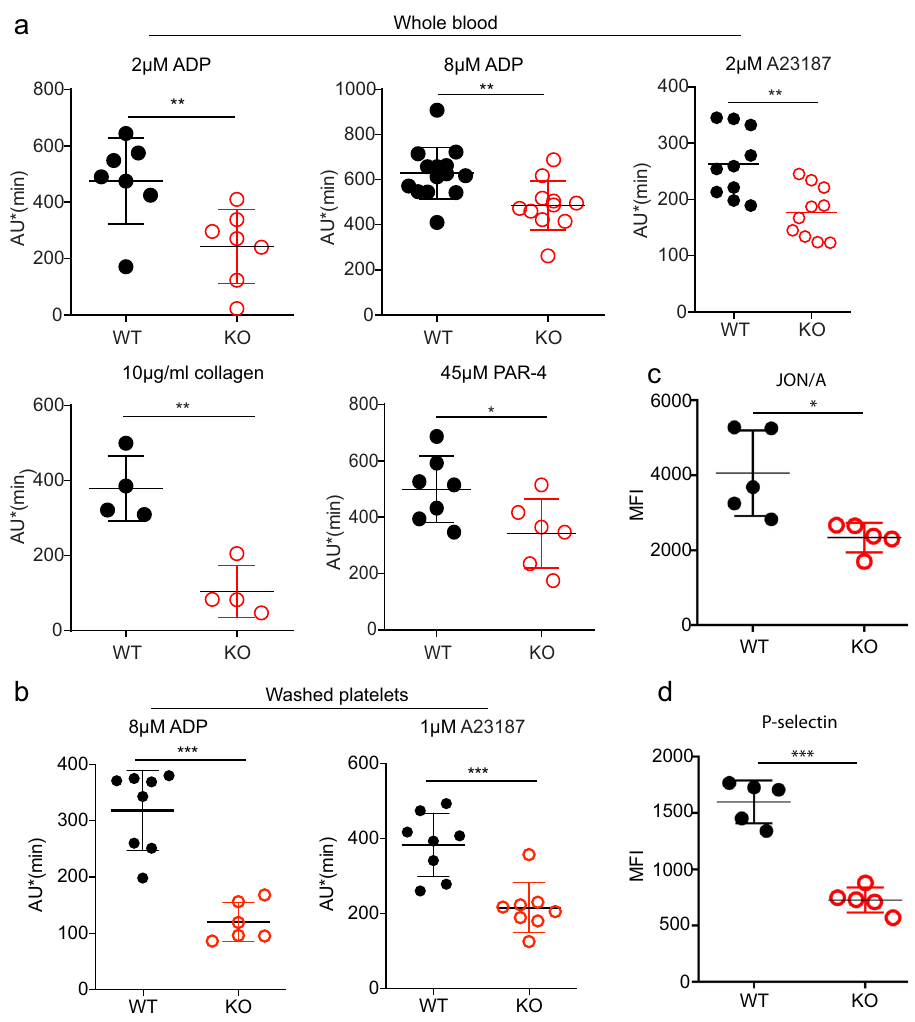
Fig. 5 Mfsd2b KO platelets exhibited reduced aggregation. a aggregation assays of whole blood isolated from WT and Mfsd2b KO mice with indicated agonists. Whole blood samples from WT and KO mice were activated with indicated concentrations of agonists. Aggregation ability was measured by an aggregometry analyzer and shown as area under the aggregation curve (AU). Data are mean and SD. Each dot represents one mouse ( n = 7 for 2 μ M ADP activation; n = 14 for WT and n = 11 for KO for 8 μ M ADP activation; n = 10 for 2 μ M A23187 activation; n = 4 for 10 μ g/ml collagen activation; n = 7 for WT and n = 6 or KO for 45 μ M PAR-4 activation experiments). ** P < 0.01, two-tailed unpaired t -test was used. ADP adenosine diphosphate, A23187 calcium ionophore, PAR-4 protease-activated receptor-4, JON/A platelet glycoprotein GPIIb/IIIa. b aggregation assays of washed platelets isolated from WT and KO mice with indicated agonists. Washed Mfsd2b knockout platelets exhibited signi fi cantly impaired aggregation compared with WT controls as observed in the whole blood samples. Data are mean and SD. Each dot represents one mouse ( n = 8 for WT and n = 6 for KO for 8 μ M ADP activation; n = 8 for 1 μ M A23187 activation experiments). *** P < 0.001, two-tailed unpaired t -test was used. AU area under the aggregation curve. c , d Mfsd2b knockout platelets had signi fi cantly reduced expression of JON/A and P-selectin to the cell surface after activation with 1 µ M A23187. Surface expression of JON/A and P-selectin was analyzed by fl ow cytometry. See supplementary fi g. 10 for gating strategy. Data are mean and SD. Each dot represents one mouse ( n